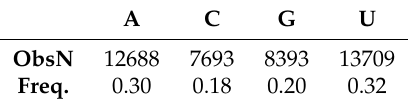
Table 2. Statistics of